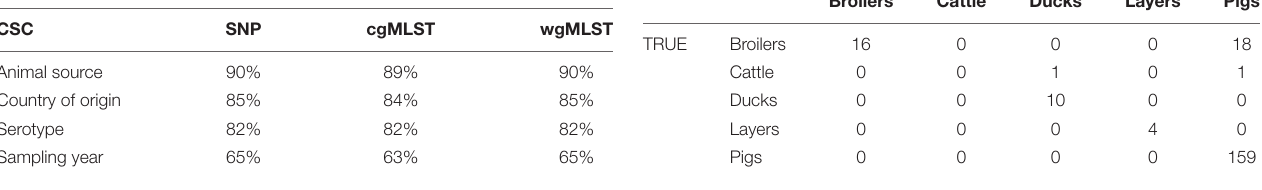
TABLE 4 | Coherent source clustering (CSC) for SNP, cgMLST, and wgMLST distance matrix, computed on animal origin isolates, according to the following parameters: animal source, serotype, country of origin, and sampling